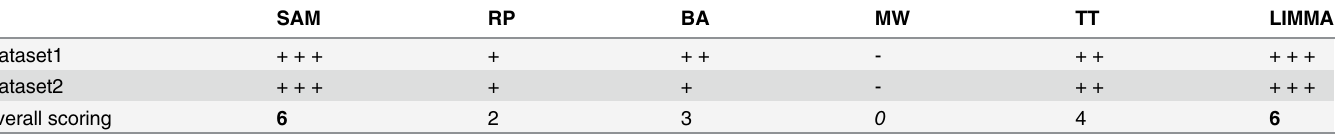
S1 Fig. Venn diagram for